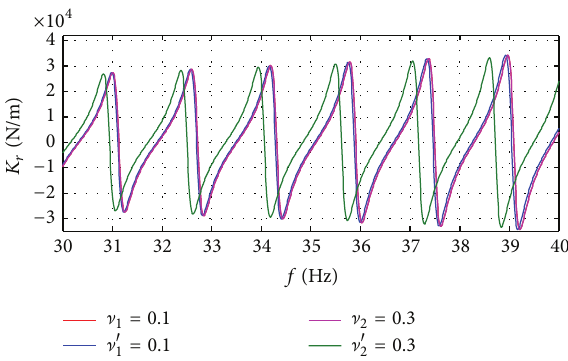
Figure 6: Influence of Poisson’s ratio on dynamic stiffness.